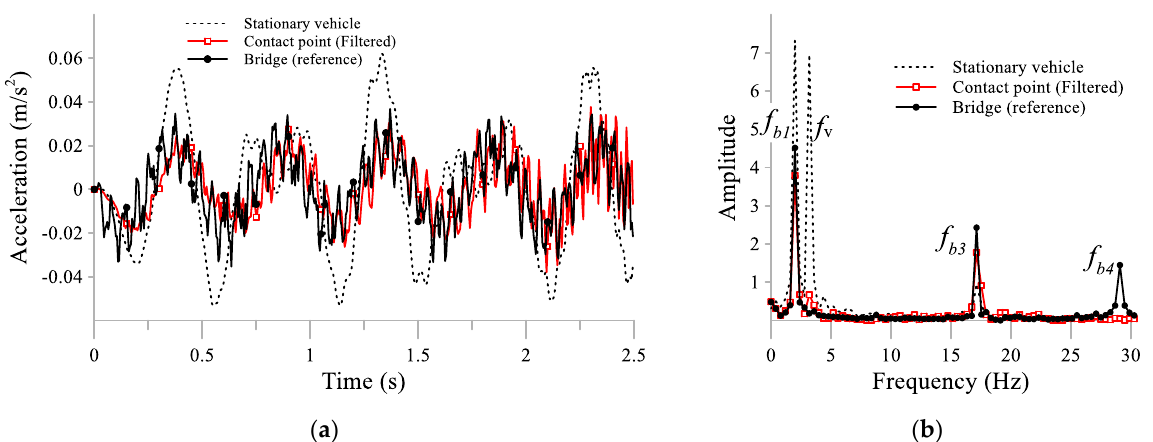
Figure 15. Filtering the contact-point signal of the undamped stationary vehicle ( a ) acceleration response and ( b ) the acceleration spectra.